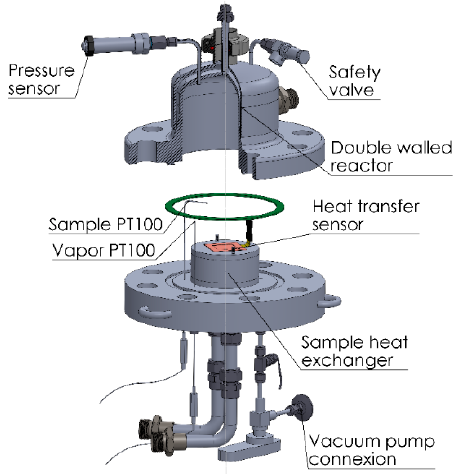
Figure 4. Reactor and sensors of the macrokinetic installation.